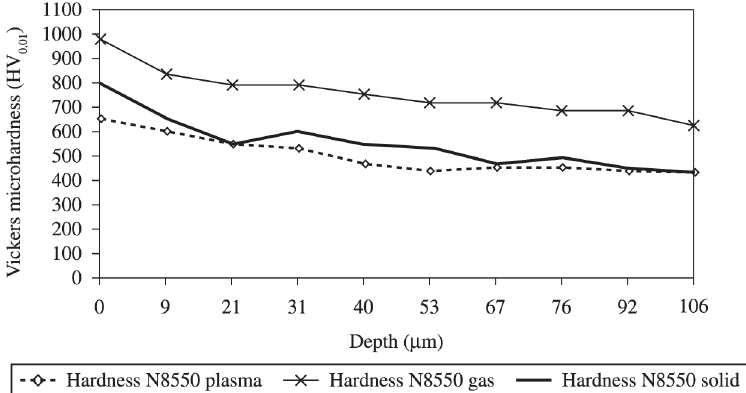
Figure 5. Microhardness profile for samples of N-8550, nitrided by three different processes (plasma, gas, and solid (10h)).